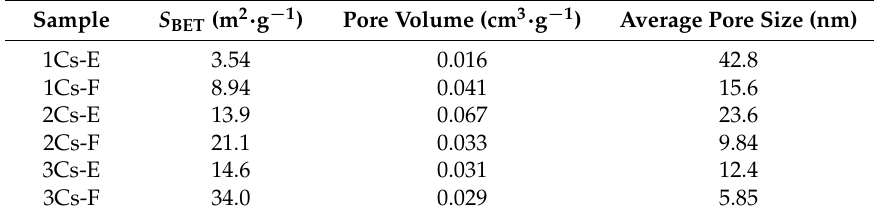
Figure 6. Pore size distribution of the samples. Table 3. Textural properties of the samples.